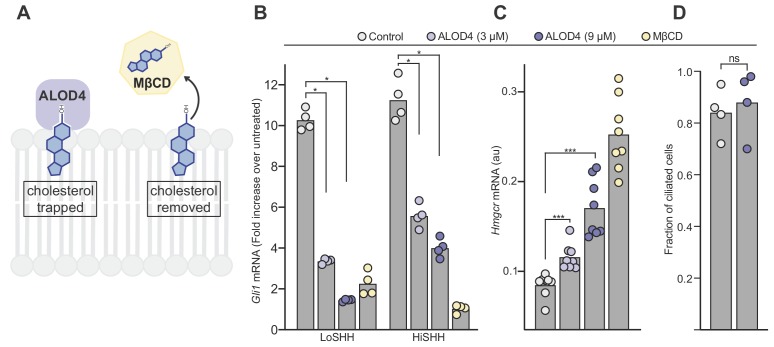
ALOD4 impairs hedgehog signaling by trapping accessible cholesterol.(A) ALOD4 and MβCD reduce accessible cholesterol by different mechanisms. ALOD4 binds and traps accessible cholesterol in the outer leaflet of plasma membranes of intact cells, without changing total cholesterol abundance. MβCD removes cholesterol from membranes, reducing both accessible and total cholesterol. (B) HH signaling triggered by five hours of LoSHH (5 nM) or HiSHH (30 nM) treatment following pre-treatment of cells with ALOD4 (3 or 9 µM) or MβCD (2 mM) for 1 hour. Bars denote the mean value derived from the four individual measurements shown. (C) Hmgcr mRNA levels measured with qRT-PCR after treatment with the same conditions as in (B). Bars denote the mean value derived from the eight individual measurements shown. (D) Ciliation frequency of cells after ALOD4 treatment (same conditions as in B), calculated as the number of cilia over the number of nuclei. Each point represents the ciliation frequency (derived from >30 cells) in a different imaging field. Statistical significance was determined by the Mann-Whitney test (B–D); p-values are: (B) p-value=0.0286 (all comparisons), (C) p-value=0.0002 for both comparisons, and (D) p-value=0.4857.